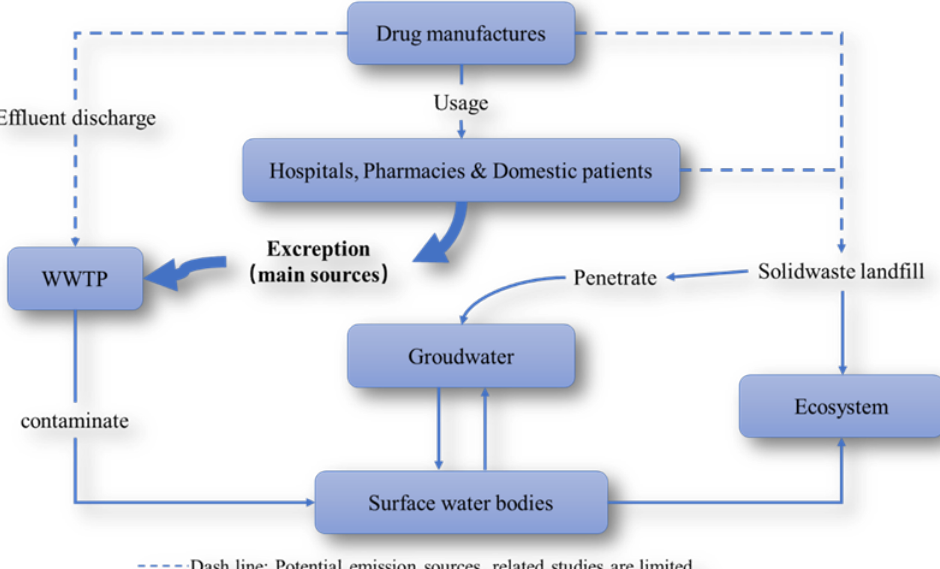
Figure 4. Routes through which platinum-based anticancer drugs are input and transported in the environment. Table 1. Predicted PEC concentrations (ng L − 1 ) of carboplatin, oxaliplatin, and cisplatin in France, in the years 2004 and 2008